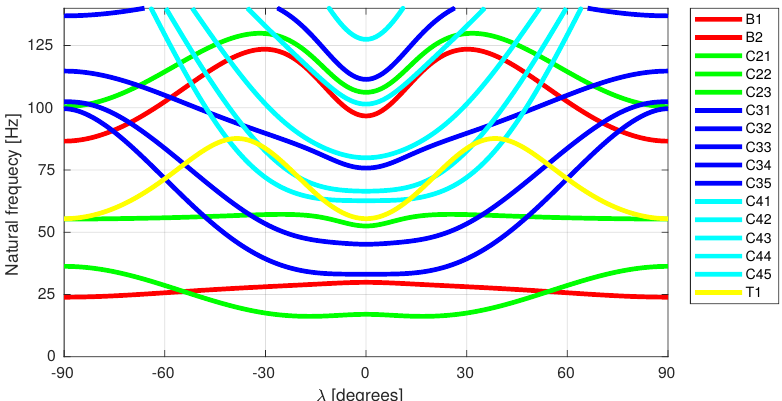
Figure 3. Natural frequencies variations in 3-layer cylinder, stacking sequence [ λ /0/ λ ]